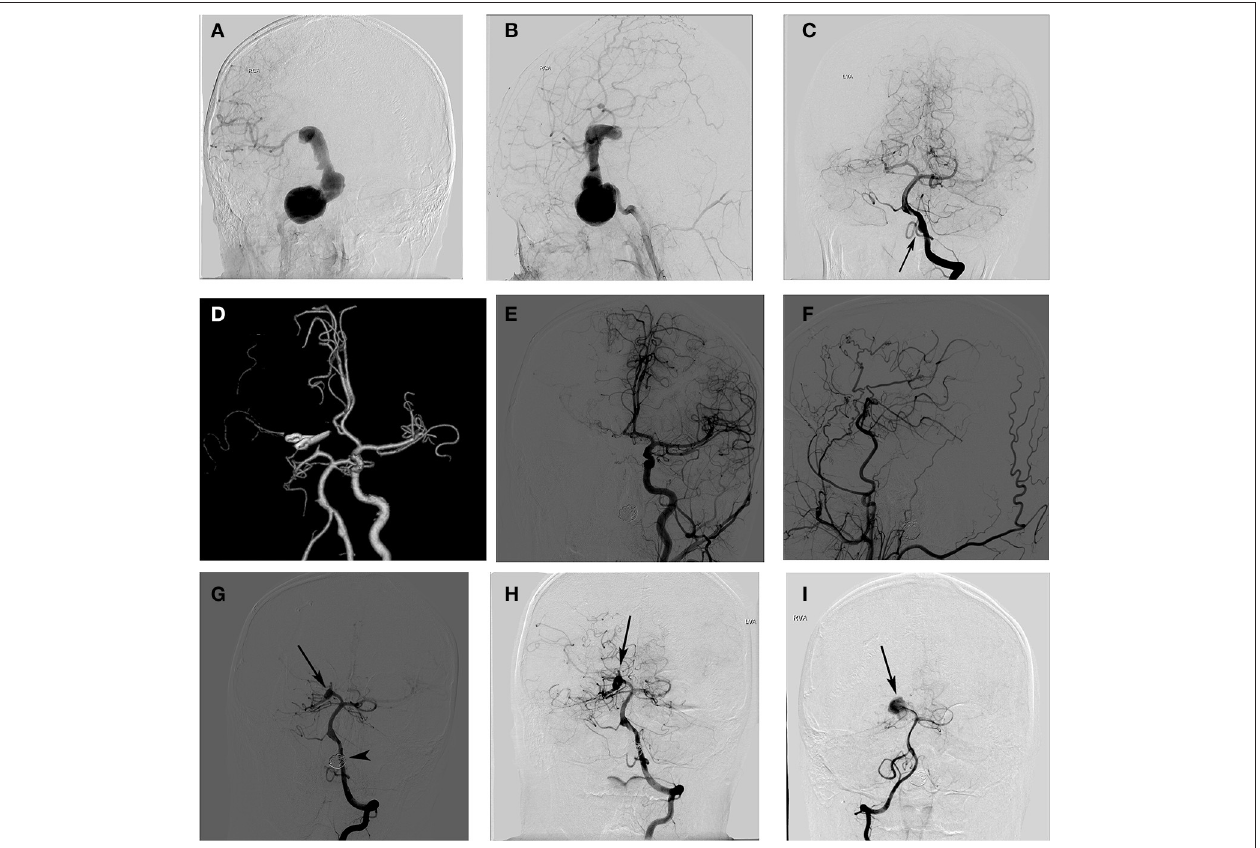
FIGURE 1 | A schoolboy presented with blurred vision and headache. The right internal carotid artery (ICA) angiogram shows a giant ICA aneurysm (A,B) , and the left vertebral artery (LVA) angiogram shows a dissecting aneurysm (C) . Postoperative CT angiography showed complete obliteration of the aneurysm (D) . The angiograms of the left (E) and right ICA (F) 2 years later showed no recurrent aneurysm and a good filling of the distal middle cerebral artery (MCA) branches via the bypass. Anterior projections of the left VA angiogram (G) showed complete occlusion of the left VA aneurysm (arrowhead) and a de novo aneurysm formation of the right posterior cerebral artery (PCA) (arrow). A follow-up angiogram of the right PCA showed no aneurysm enlargement 18 months after it was detected (H) and a significant aneurysm enlargement 5 years after it was detected (I)